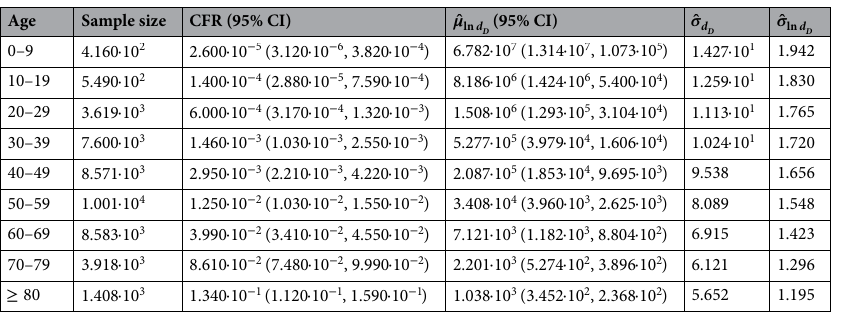
and ̂𝜎 ln d , are D D